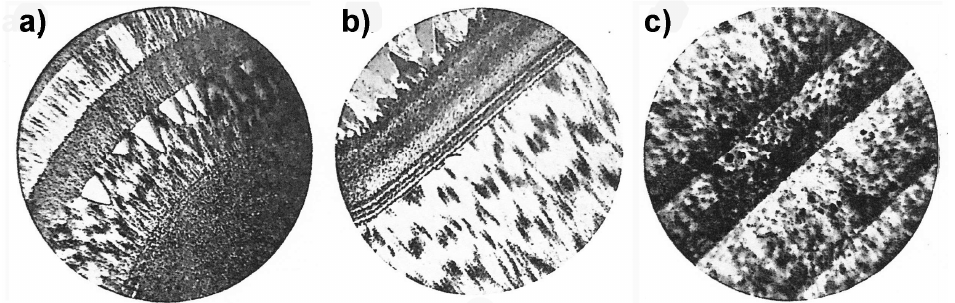
Figure 1. Timofeev micrographs [8]. The original captions describe the ( a ) alternation of zones of quartz (light) and chalcedony (dark); ( b ) the formation of quartzine filaments on the faces of the quartz rhombohedra; and ( c ) zones showing a changing orientation from chalcedony to quartz. Liesegang [2] had made several publications on rhythmic banding in silica gels and by 1915 he